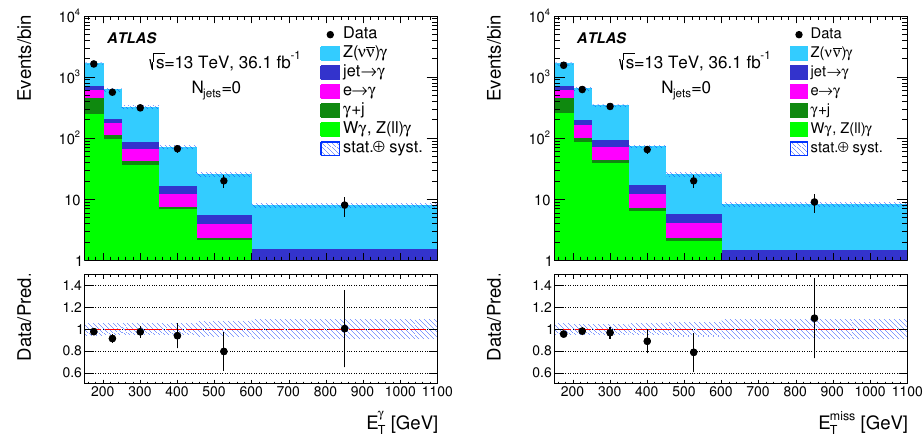
Figure 3 . Left: photon E T distribution; right: missing transverse momentum distribution, in the exclusive ( N jets = 0) signal region. MC expectations are scaled to the integrated luminosity of the data using the expected MC cross section of each sample. The W(cid:13) and (cid:13) +jet backgrounds are scaled by an additional normalization factor from the (cid:12)t to data in the corresponding control regions. Backgrounds arising from electron or jet misidenti(cid:12)cation as a photon are estimated with the data- driven techniques described in the text. The dashed band represents the sum in quadrature of systematic and statistical uncertainties of both the background and signal expectation, and includes a contribution arising from the uncertainty in the integrated luminosity of the data